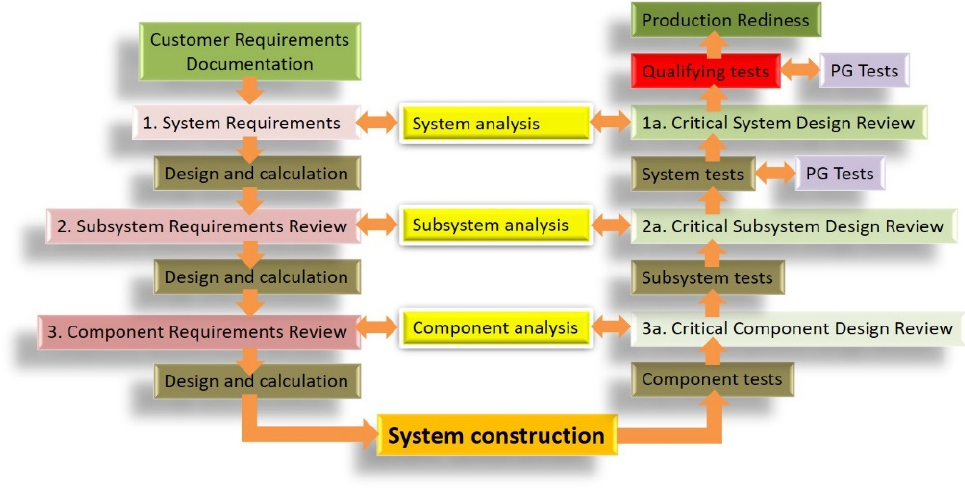
Figure 1. A model of the system design process based on a NASA V model [8].